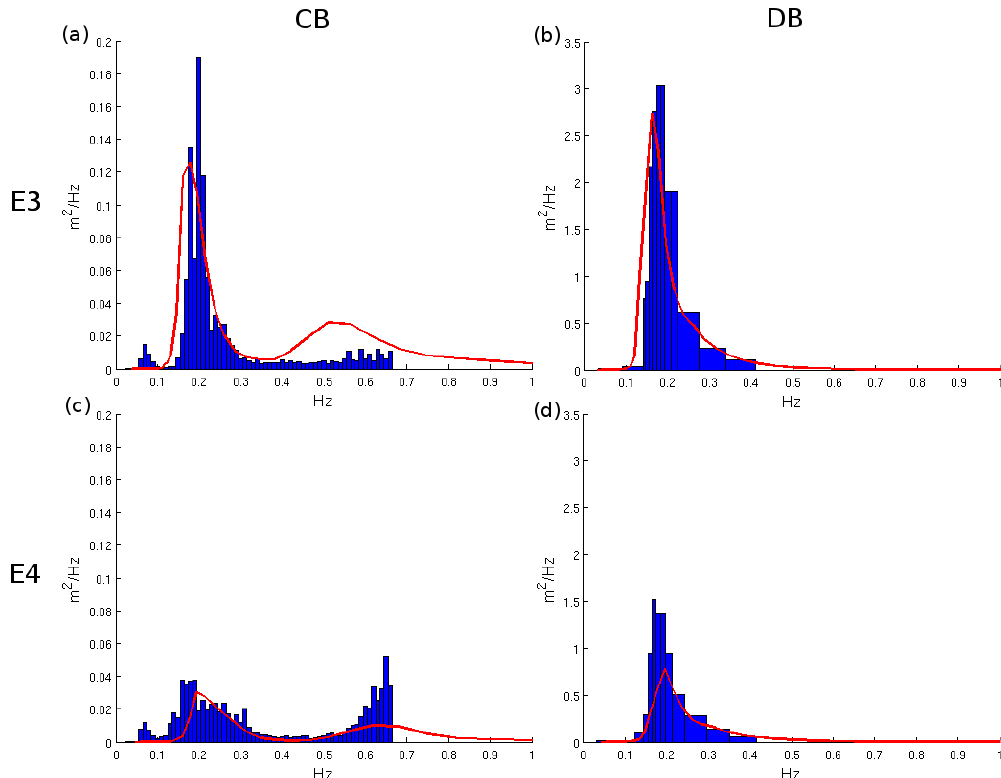
Figure 6. 1D wave spectra comparison between the model results (red line) and the spectra measured at DB and CB (blue histogram) at two time instants. ( a ) At CB within E3, ( b ) at DB within E4, ( c ) at CB within E4 and ( d ) at DB within E4. Note the different y scale for the two